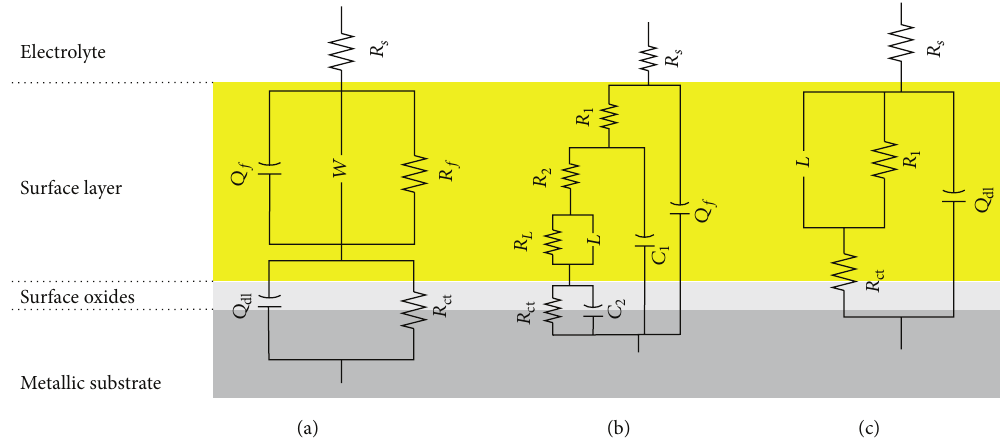
Figure 14: Equivalent circuits (a) for Ni, Cu; (b) for Al; and (c) for intermetallic alloys.